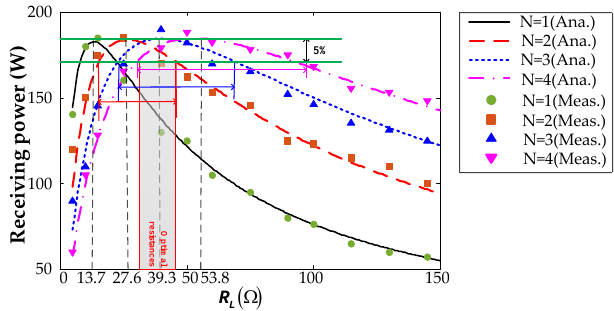
Figure 9. Receiving power versus load resistance for different numbers of EVs.